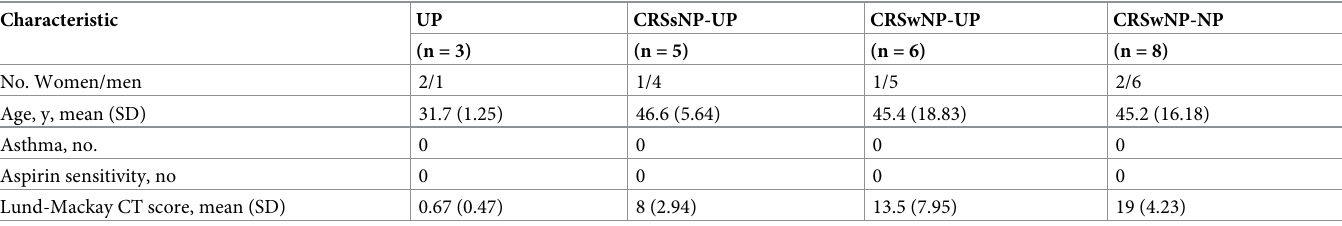
Table 1. Clinical characteristics of patients (N =